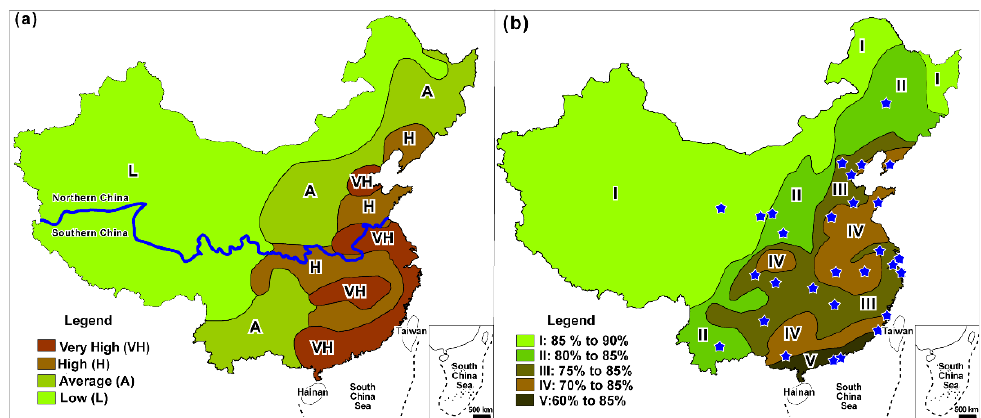
Figure 1. Generalized waterlogging risk in China ( a ). Key to the legend: very high (VH), high (H), average (A), low (L). Percentage of the urban runoff aimed to be controlled by the Sponge City plan ( b ). Key to the legend: 85% to 90% (I), 80% to 85% (II); 75% to 85% (III); 70% to 85% (IV); 60% to 85% (V). Blue stars indicate the pilot sites of the Sponge City Project. Redrawn from MOHURD 2014.